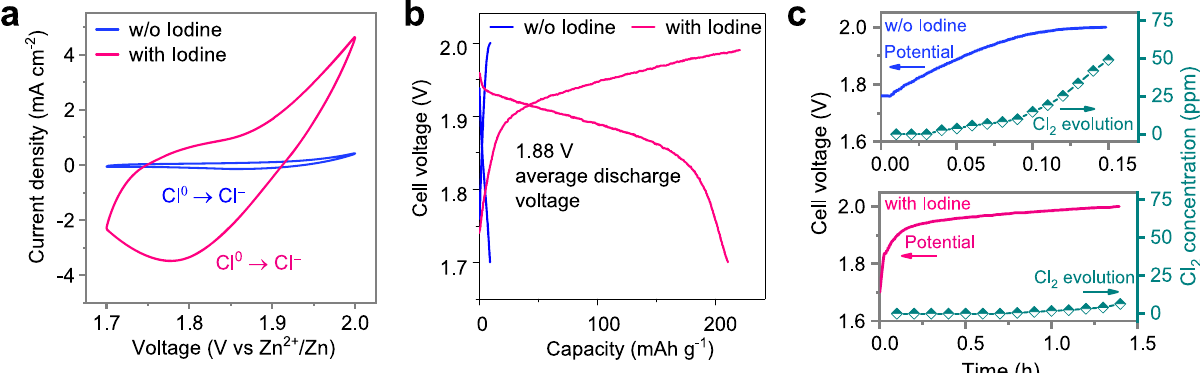
Fig. 1 | Electrochemical characterizations ofiodine activity towardsClRR.a CV pro fi les at 1mVs − 1 and b GCD pro fi les of the I-containing electrode cycled at 0.5A g I2 − 1 , and I-absent electrode cycled at 0.5A g AC − 1 based on AC mass, both in 30m